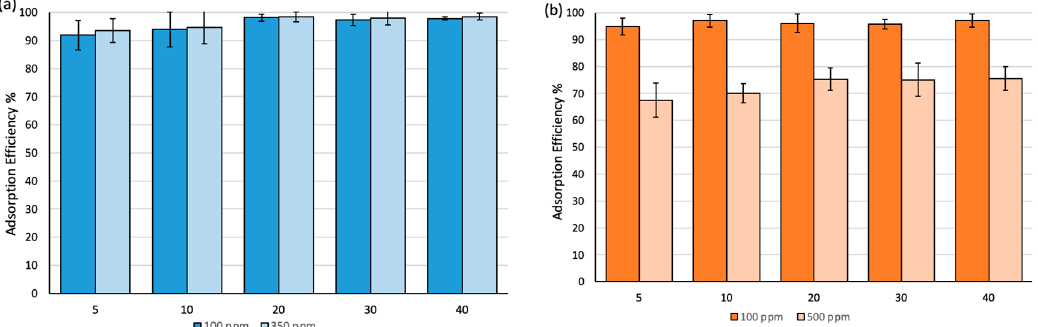
Figure 6. Adsorption efficiency (%) at different exposure times: ( a ) Fe 3 O 4 -MSNs-PMETAC in bro- mothymol blue solution at pH = 7 and 25 °C, ( b ) Fe 3 O 4 -MSNs-PMETAC in methyl orange solution at pH = 7 and 25 °C.